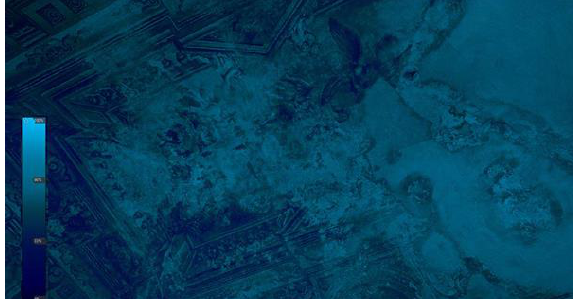
Figura 12. RGB three-dimensional view of the dense cloud: detail of the chromatic differences of the plaster in the points where the chains have been